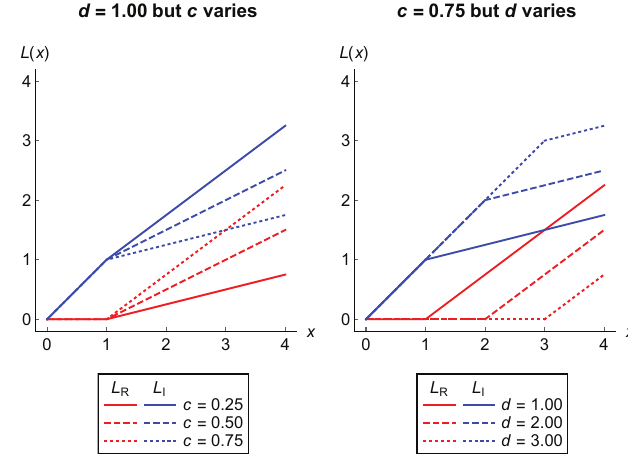
Figure 1. The curves of the ceded loss function L R and the retained loss function L I in the presence of the combined stop-loss and quota-share reinsurance when d is fixed but c varies (on the left side) and when c is fixed but d varies (on the right